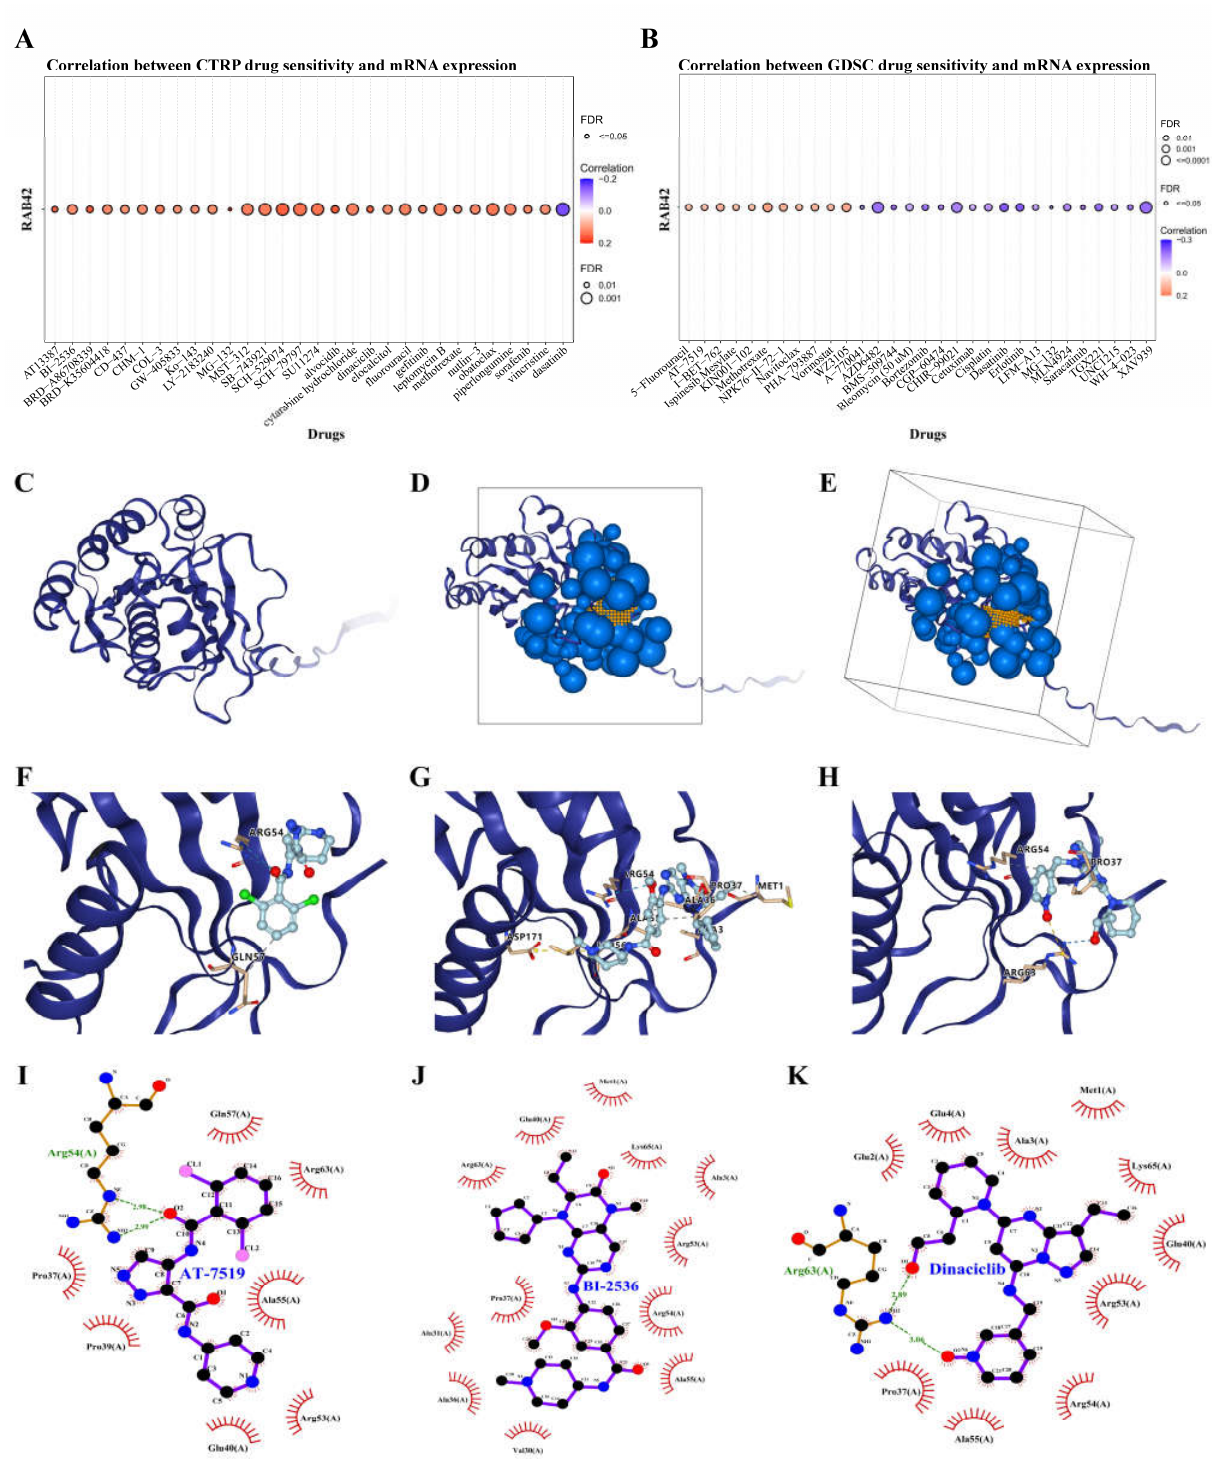
Figure 9. Screening susceptible drugs for the RAB42 protein. ( A , B ) Predicted drugs sensitive for RAB42 by the GDSC and CTRP datasets. ( C ) The 3D structure of the RAB42 protein. ( D , E ) The binding site and box of the RAB42 protein. Small orange spheres represent binding site, black solid lines represent binding box. ( F – H ) The 3D docking conformations of AT-7519, BI-2536 and Dinaciclib with the RAB42 protein. Labels represent amino acid residues; blue dashed line represents hydrogen bond; yellow dashed line represents salt bridge (ionic bond); gray dashed represents hydrophobic interaction. ( I – K ) The interaction forces between amino acid residues of the RAB42 protein and AT-7519, BI-2536 or Dinaciclib. Green dashed line represents hydrogen bonds.